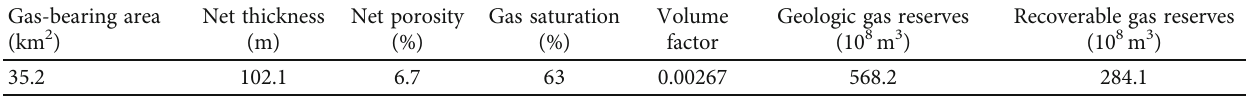
Figure 14: Distribution of pore-throat radius, cut o ff values, and their percentages in total pore spaces in tight sandstone reservoirs of Ahe Formation in Dibei area. Table 3: Calculation parameters and results of tight sandstone gas reserves in Dibei area. Gas-bearing